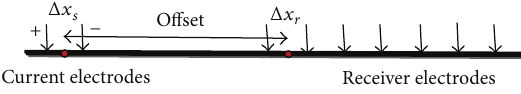
Figure 5: MTEM acquisition